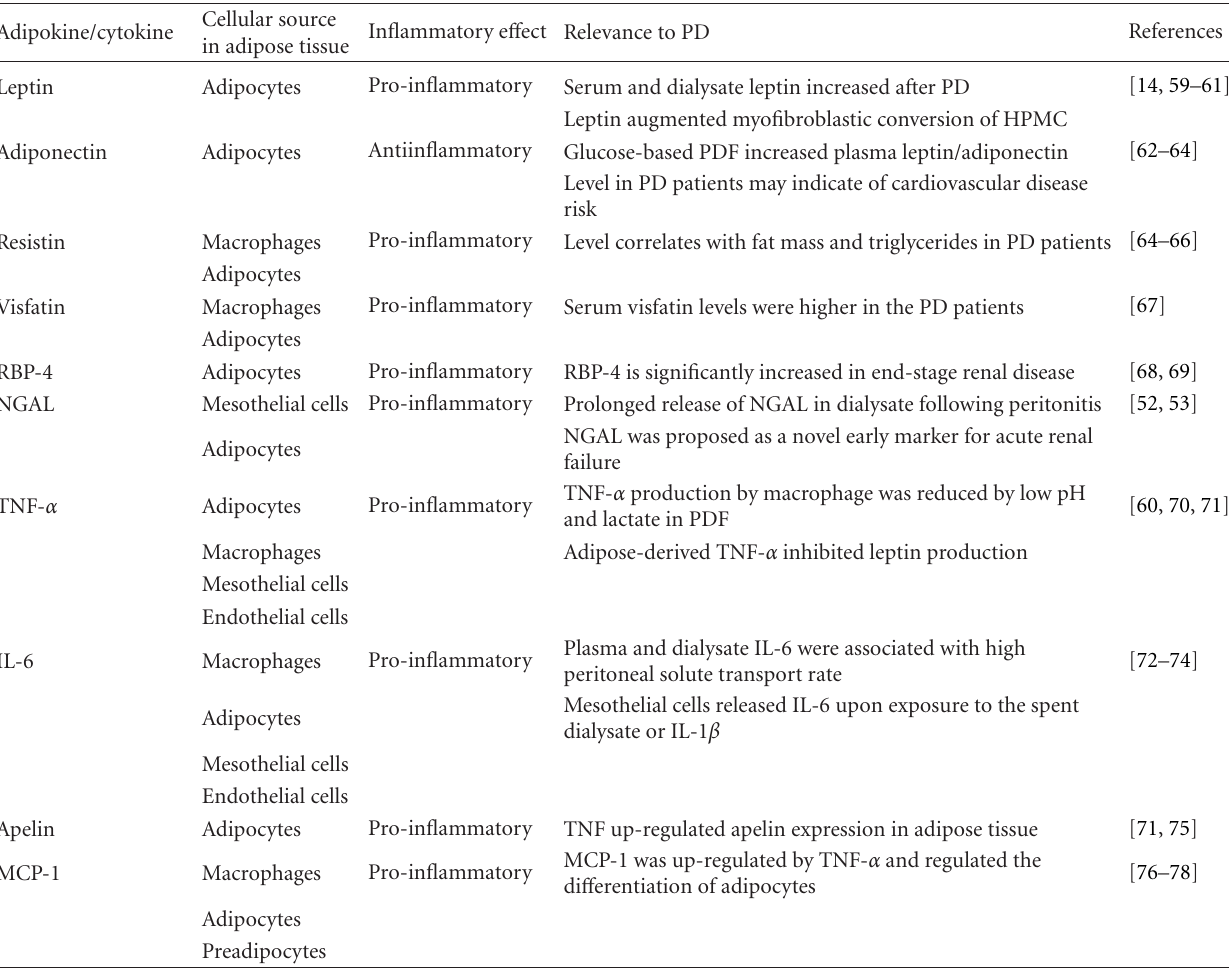
Table 1: Major adipokines and cytokines released from adipose